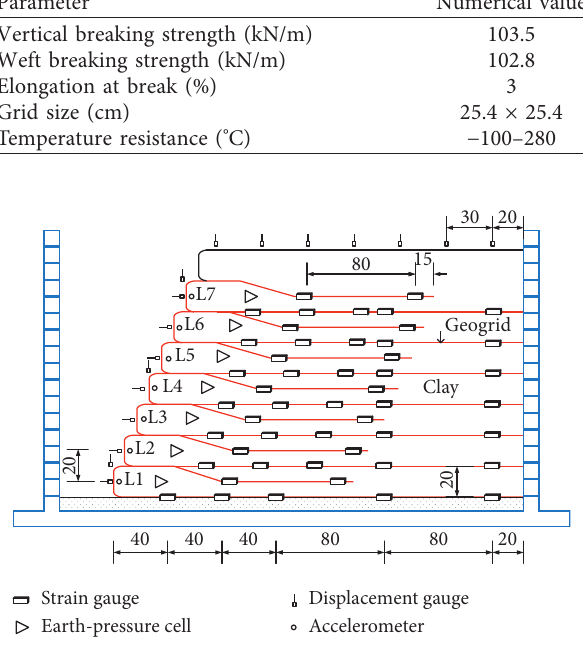
Figure 3: Sensor layout